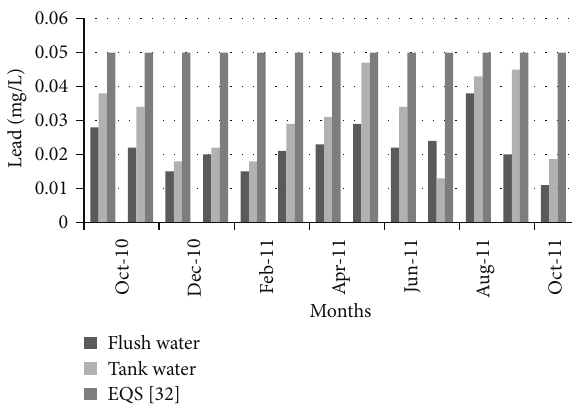
Figure 16: Variation of lead over time.